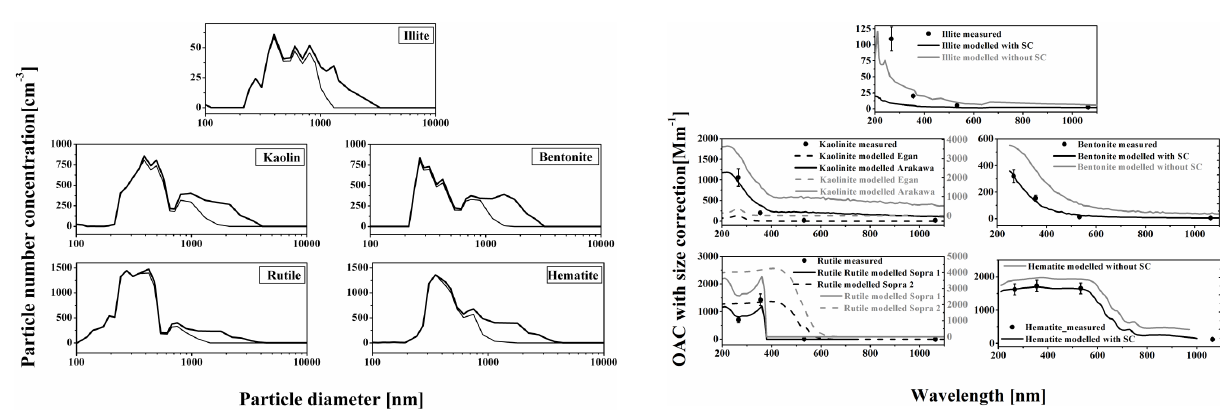
Figure 2. Number size distributions: in the buffer chamber mea- sured by the SMPS and the OPC instruments (thick line) and in the PA cell calculated from the SMPS + OPC data by taking into ac- count the calculated size transfer function of the PA system (thin line).